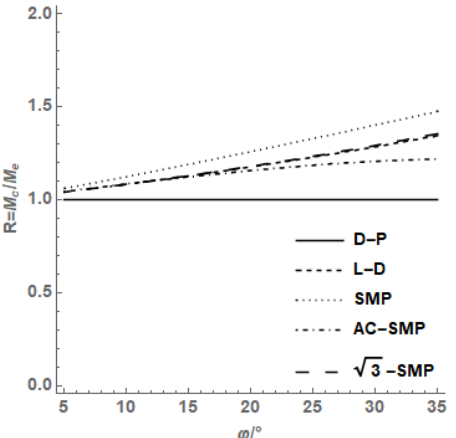
Figure 6. Changes of strength ratio with 𝜑 on symmetrical compression and extrusion.